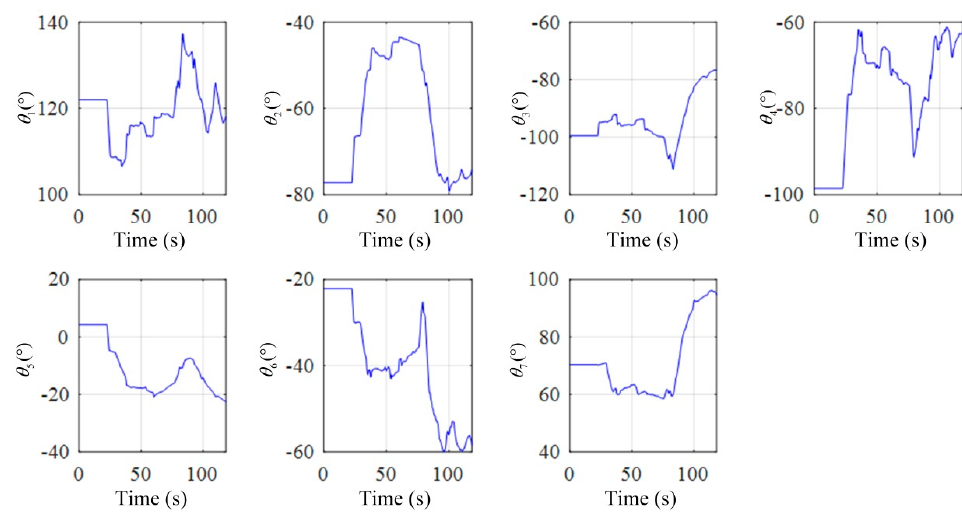
Figure 15. Actual joint trajectory with virtual impedance mapping.